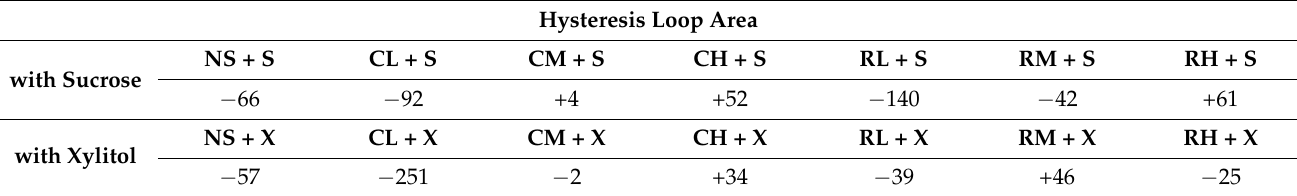
Table 2. Hysteresis loop size of blackberry jelly-like desserts. Hysteresis Loop